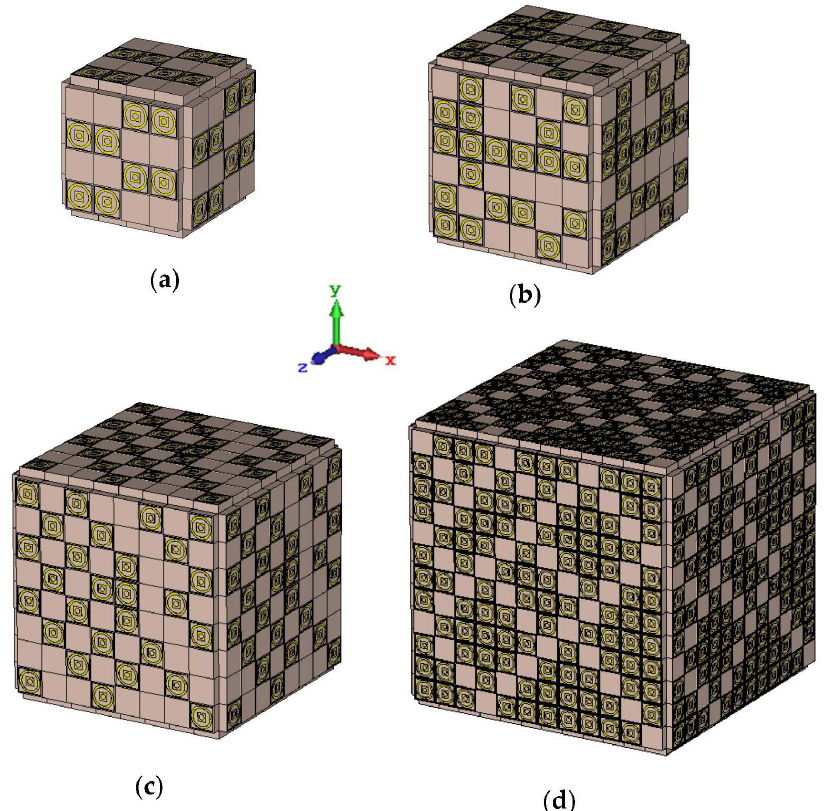
Figure 13. Cuboid coding metamaterial structures of ( a ) Coding Sequence 3 with 4 lattices; ( b ) Cod- ing Sequence 2 with 6 lattices; ( c ) Coding Sequence 3 with 8 lattices; and ( d ) Coding Sequence 3 with 12 lattices.